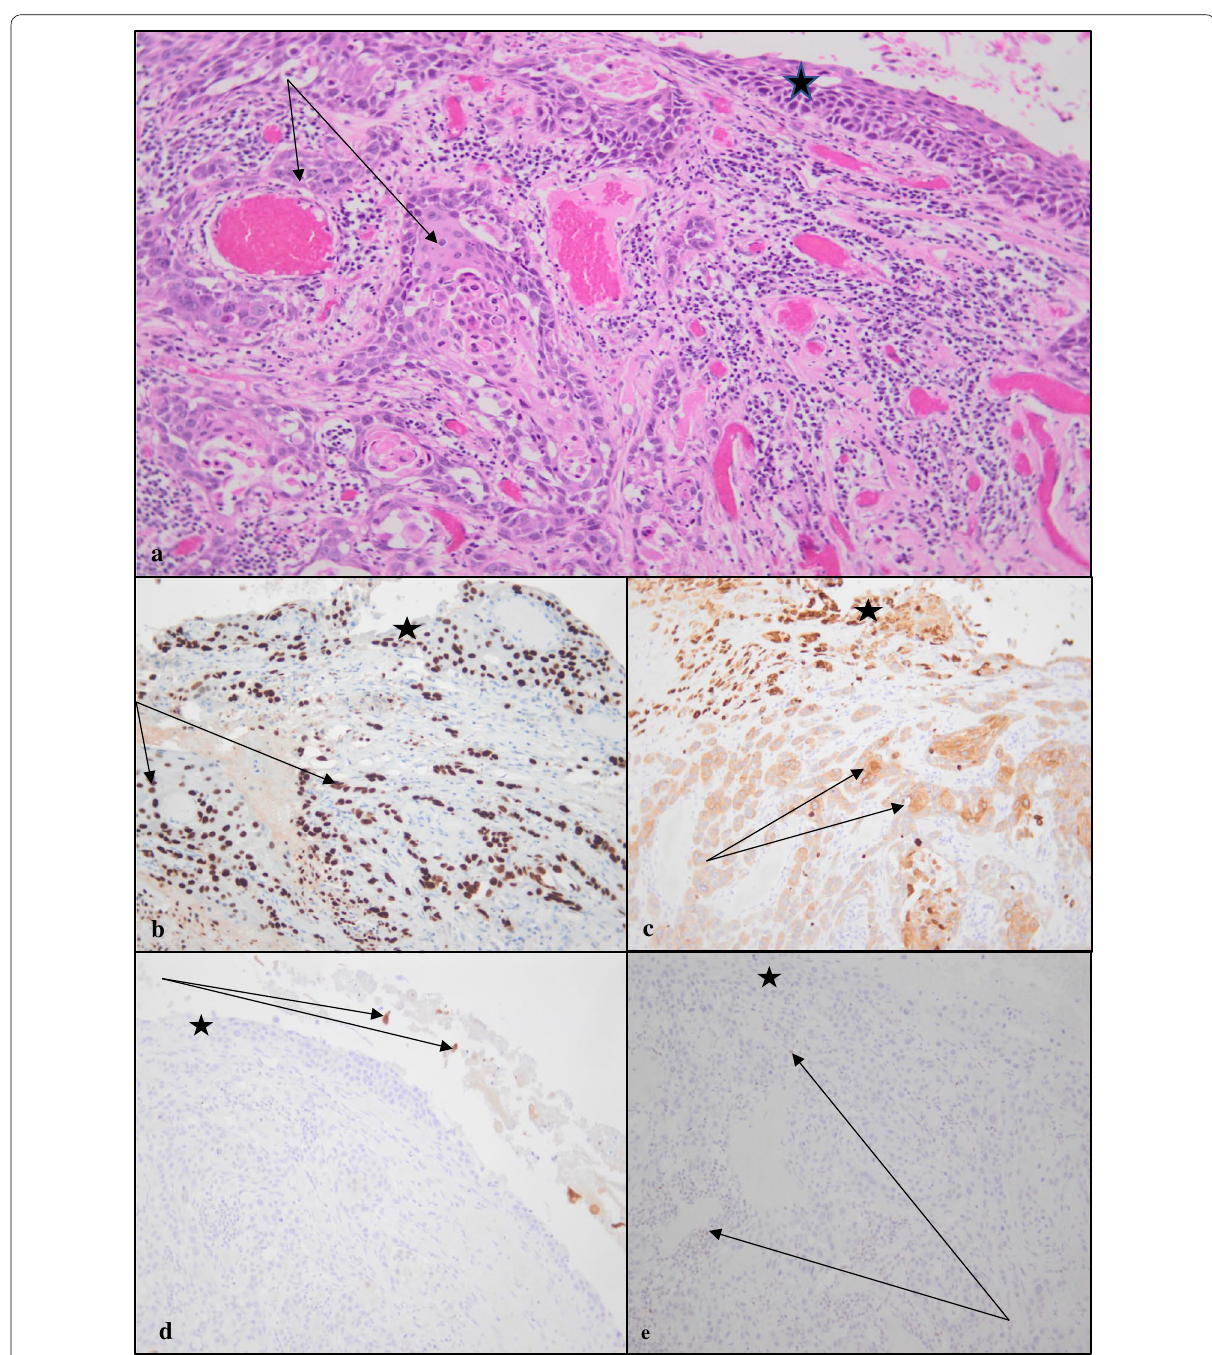
Fig. 5 a Haematoxylin and eosin (H&E) photomicrograph showing dysplastic squamous mucosa (star) with islands of squamous cell carcinoma within the stroma (long thin arrows). b P63 immunohistochemical stain is positive in dysplastic squamous mucosa (star) and in the invasive tumour (long thin arrows). c CK5/6 immunohistochemical stain is positive in dysplastic mucosa (star) and in the invasive carcinoma (long thin arrows). d S100P immunohistochemical stain is positive in free-lying urothelial cells (long thin arrows) but is negative in dysplastic mucosa (star) and in the invasive tumour. e GATA-3 immunohistochemical stain is positive in lymphocytes in the stroma (long thin arrows) but is negative in dysplastic mucosa (star) and in the invasive carcinoma (original magnification ×